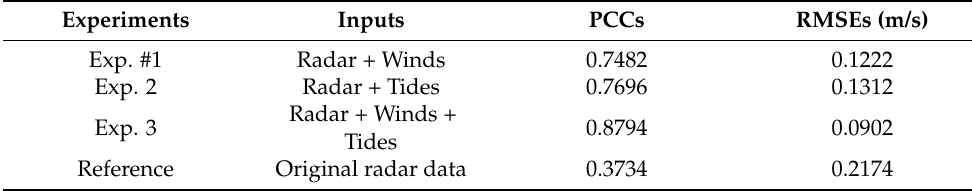
Table 2. Domain-averaged PCCs and RMSEs for the sensitivity